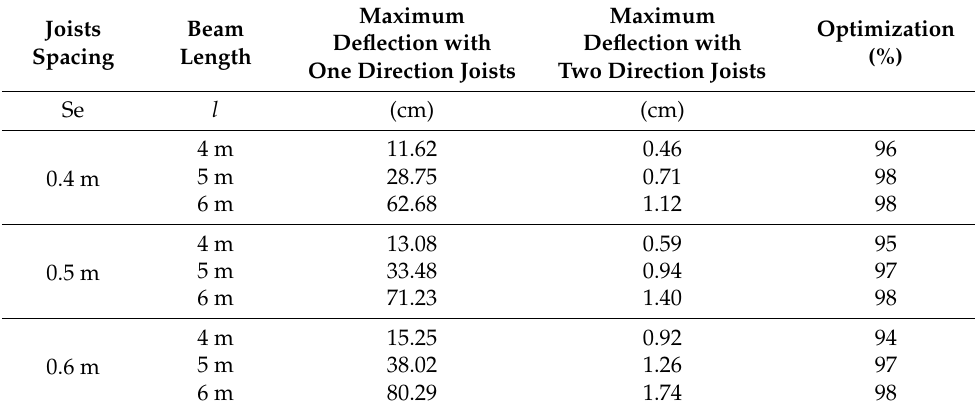
Table 11. Maximum deflection of shells with four modules.